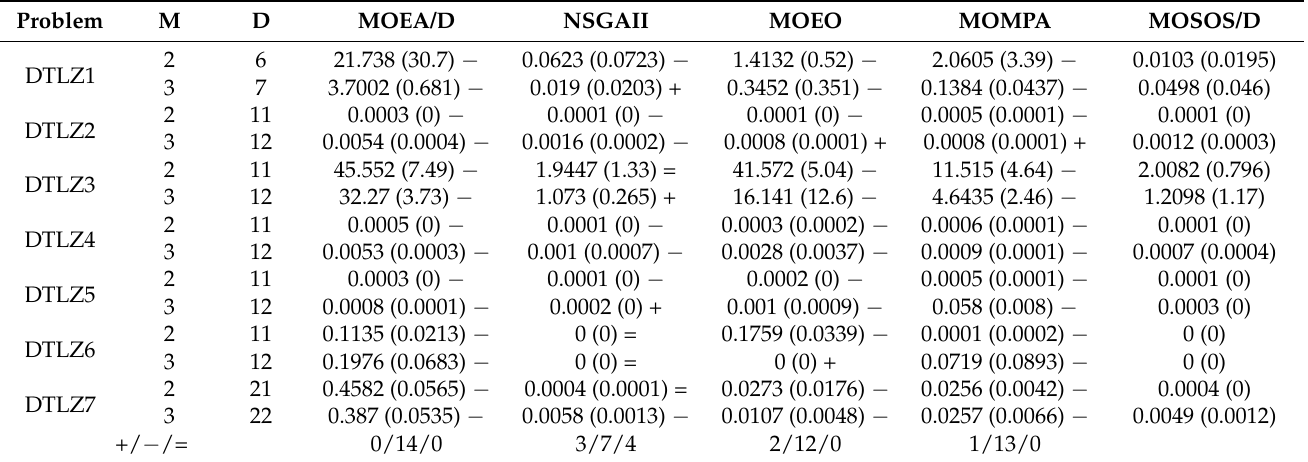
Table 1. The GD metric comparison.